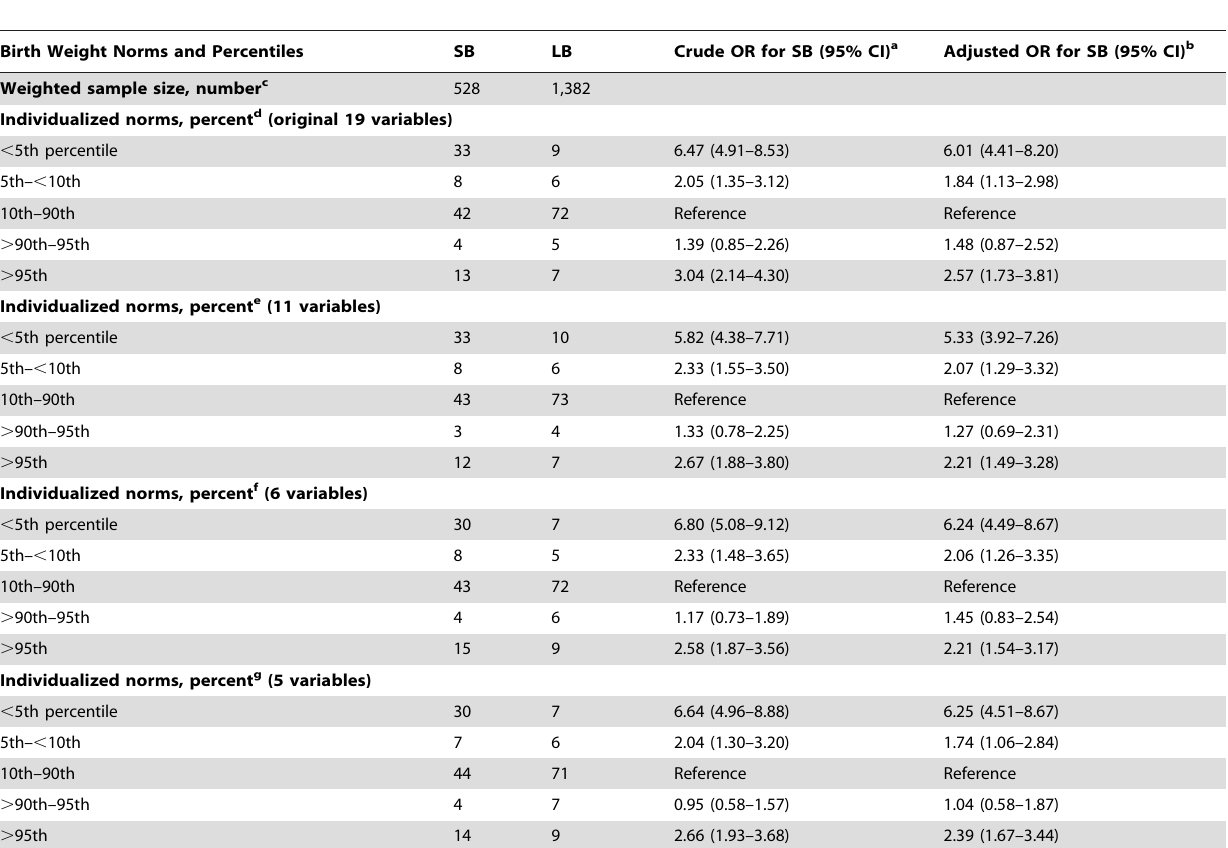
Table 3. Birth weight percentiles among stillbirths and live births using different equations to estimate individualized expected